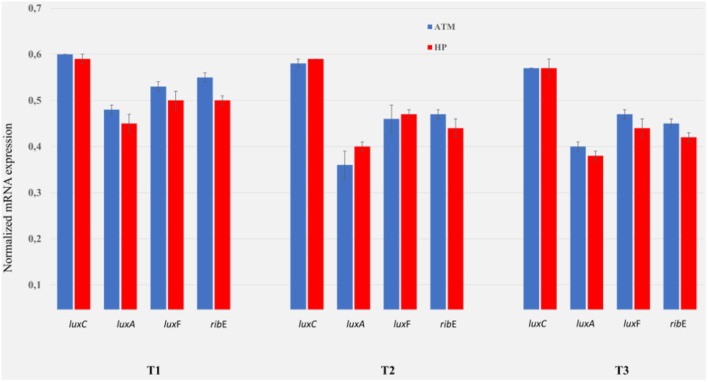
Comparison luxrib-gene-expression at atmospheric vs. high pressure of P. phosphoreum ANT-2200. Expression level of the genes luxC, luxA, luxF, and ribE at atmospheric (ATM, 0.1 MPa, blue) and at high hydrostatic pressure (HP, 22 MPa, red), for sampling times T1–T3. T1 corresponds to the initial time when the light emission is the same for both conditions (approximately 4 h). T2 and T3 correspond to the times when a bioluminescence-emission peak is reached at ATM (approximately 13 h) and HP (approximately 17 h) conditions, respectively. Reference bioluminescence and growth curves are available in Martini et al. (2013).